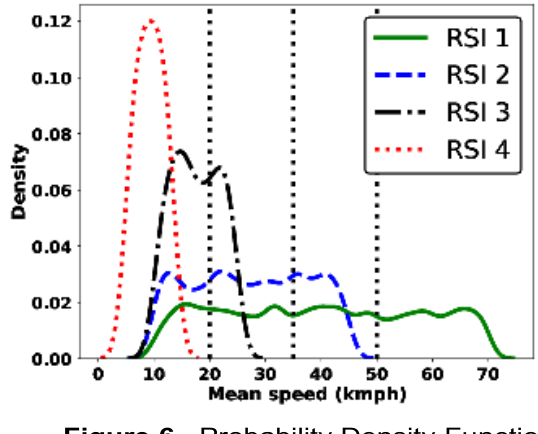
Figure 6. Probability Density Function of Mean Speed for Different Road Surface Index( R I